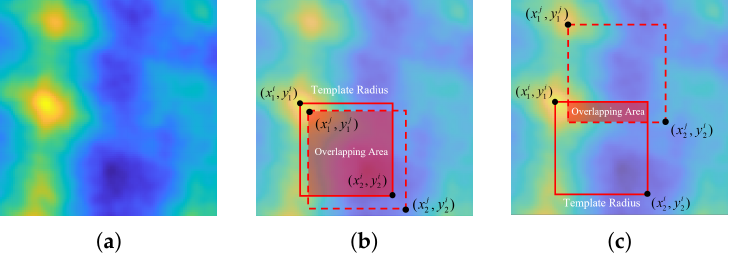
Figure 10. Non-maximum suppressed SSD fast template matching: ( a ) if there are repetitive structural features in the region, the similarity measure map may have multiple peaks; ( b ) if the area ratio of overlapping regions is larger than discriminant threshold N t , the seed point is rejected; ( c ) if the area ratio of the overlapping regions is smaller than discriminant threshold N t , keep it as a sub-peak